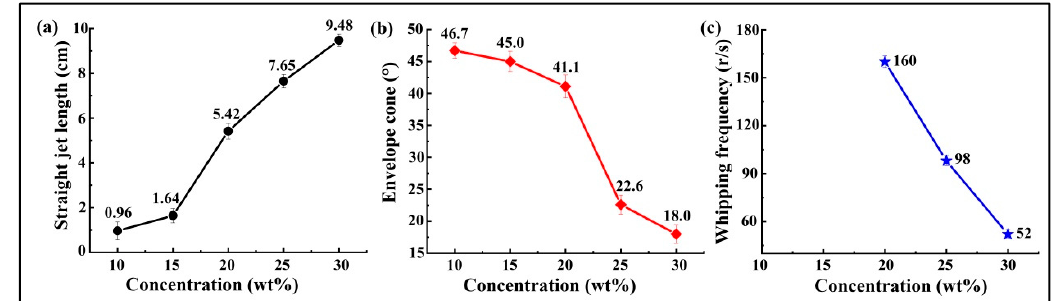
Figure 5. Whipping parameters at different solution concentrations: ( a ) Straight jet length; ( b ) envelope cone; and ( c) whipping frequency. The electrospinning processing parameters were as follows: Applied voltage of 20 kV, working distance of 20 cm, and flow rate of 1.0 mL/h.